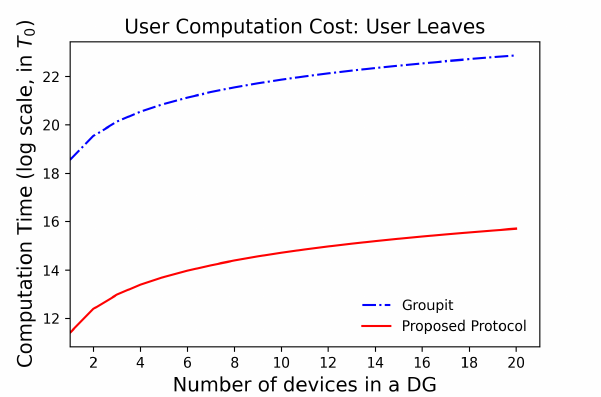
Figure 15. The figure shows the total computational load for all devices under GroupIt and the proposed protocol versus the number of devices in a DG for the case when a user leaves SG x .